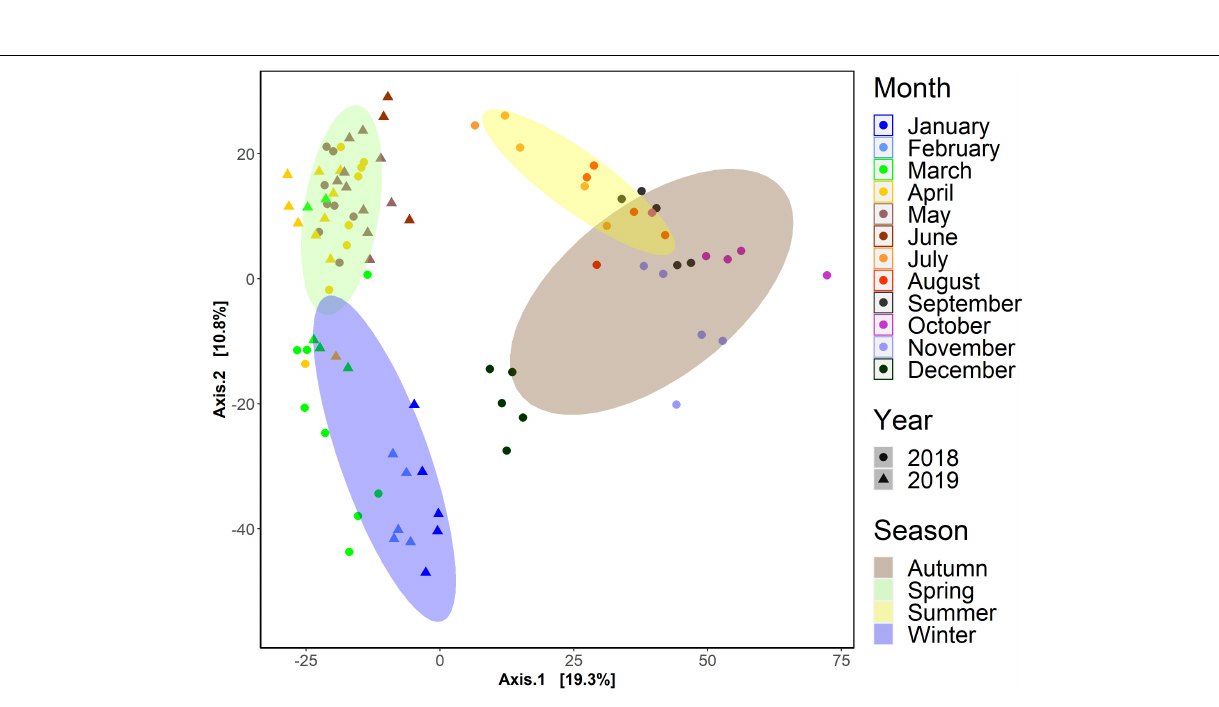
FIGURE 2 | Temporal succession of environmental contextual data for the BCZ time-series sampling. (A) PAR ( µ mol m − 2 s − 1 ) and SST ( ◦ C). (B) DIN, DIP, and DISi ( µ M) concentrations. (C) Chl- a concentration ( µ g L − 1 ) and total heterotrophic bacterial biomass (mg C m − 3 ).